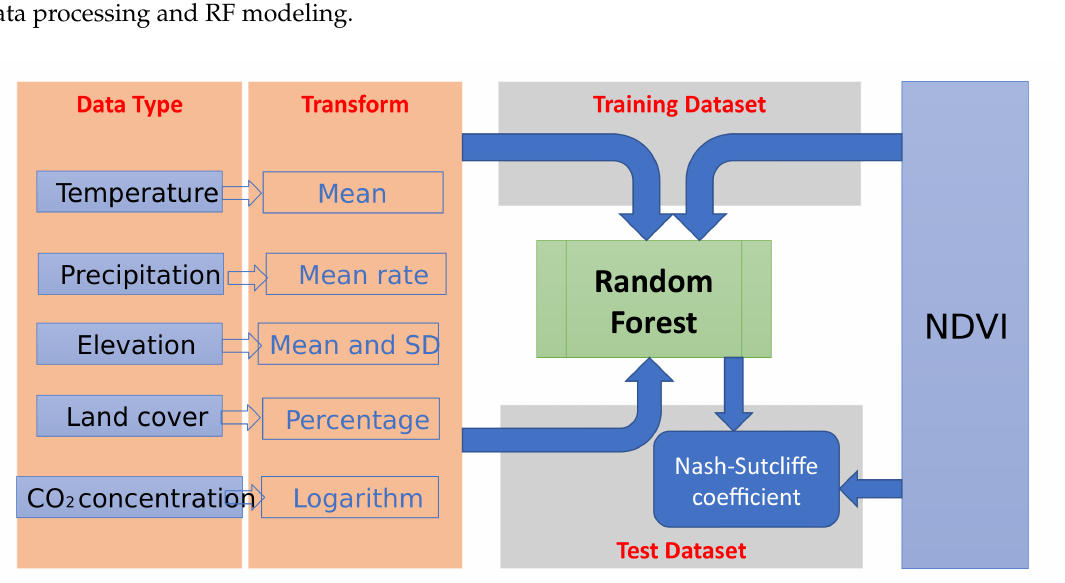
Figure 3. Overall structure of data and analysis